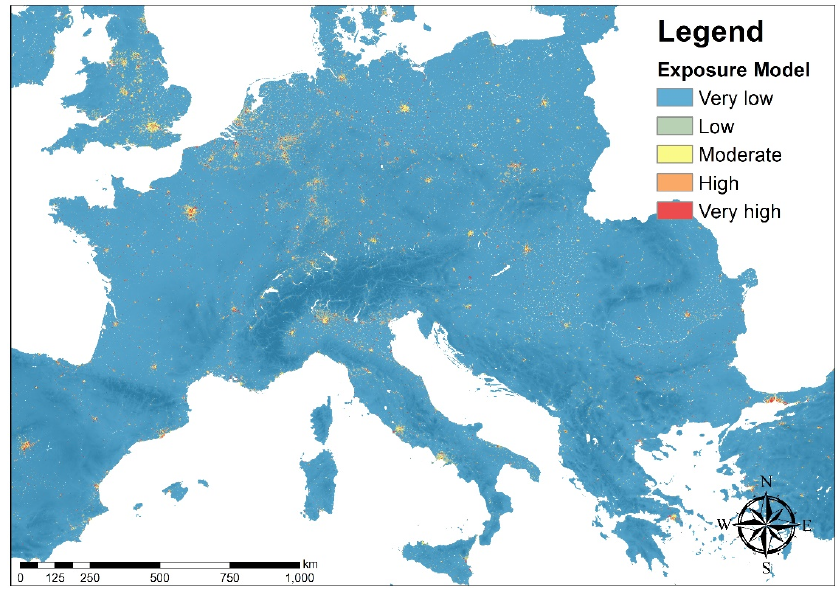
Figure 3. Exposure model for Europe adopted in this study by combining open-access data on population density and land cover in Europe, used as proxies for urbanized areas and strategic infrastructures, respectively.